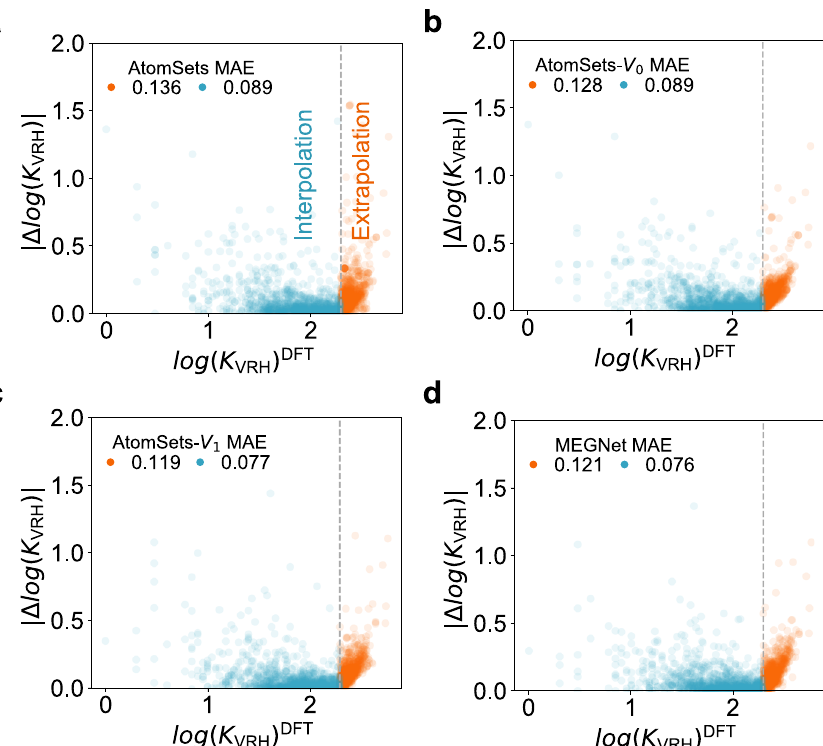
Fig. 4 Absolute differences in predicted and DFT log ð K VRH Þ , i.e., j Δ log ð K VRH Þj against the DFT value range for the test data. a – d show the AtomSets, AtomSets- V 0 , AtomSets- V 1 , and MEGNet model results respectively. The training and validation data are randomly sampled from the 0 – 90% (vertical dash line) target quantile range. Half of test data comes from the 90 – 100% quantile (extrapolation) and the other half is from the same target range as the train-validation data (interpolation).